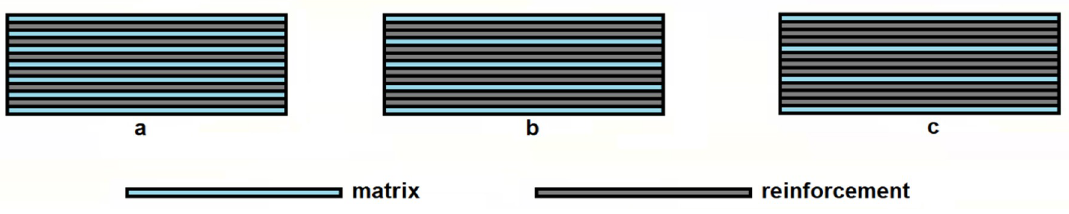
Figure 2. The arrangement of the composites: ( a ) rPP, APAO-25, APAO-50, APAO-75, APAO, ( b ) APAO-2F, ( c ) APAO-3F.